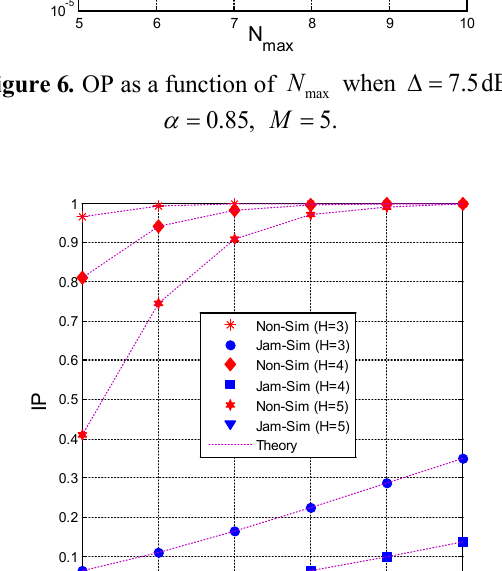
N when 7.5dB, D= max 0.85, α= 5. M